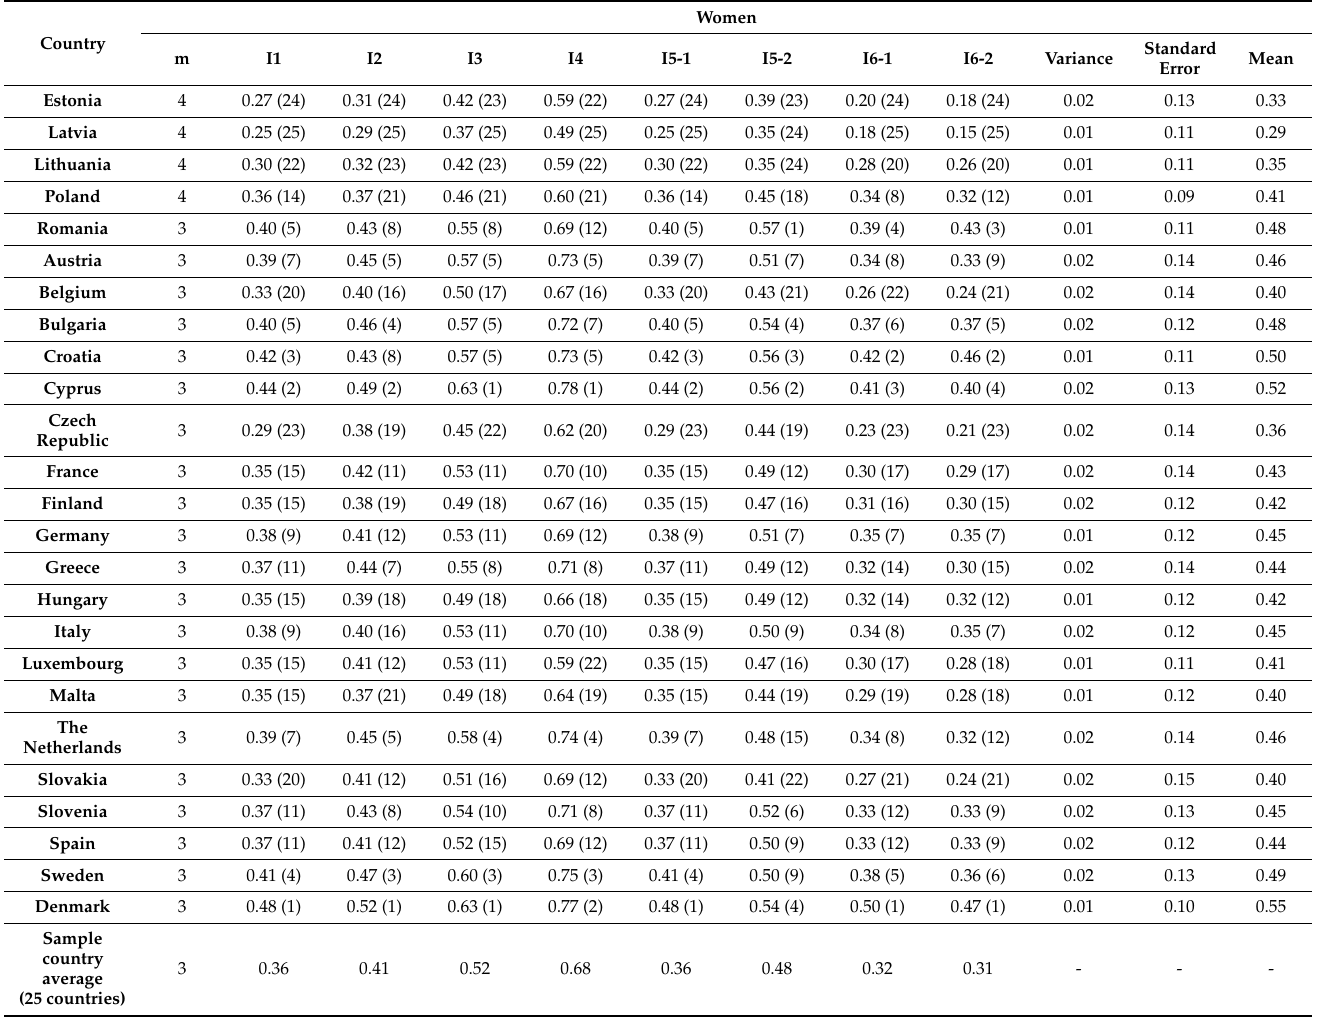
Table 10. Inequality indicators in self-perceived health in Wave 8 (2020) for